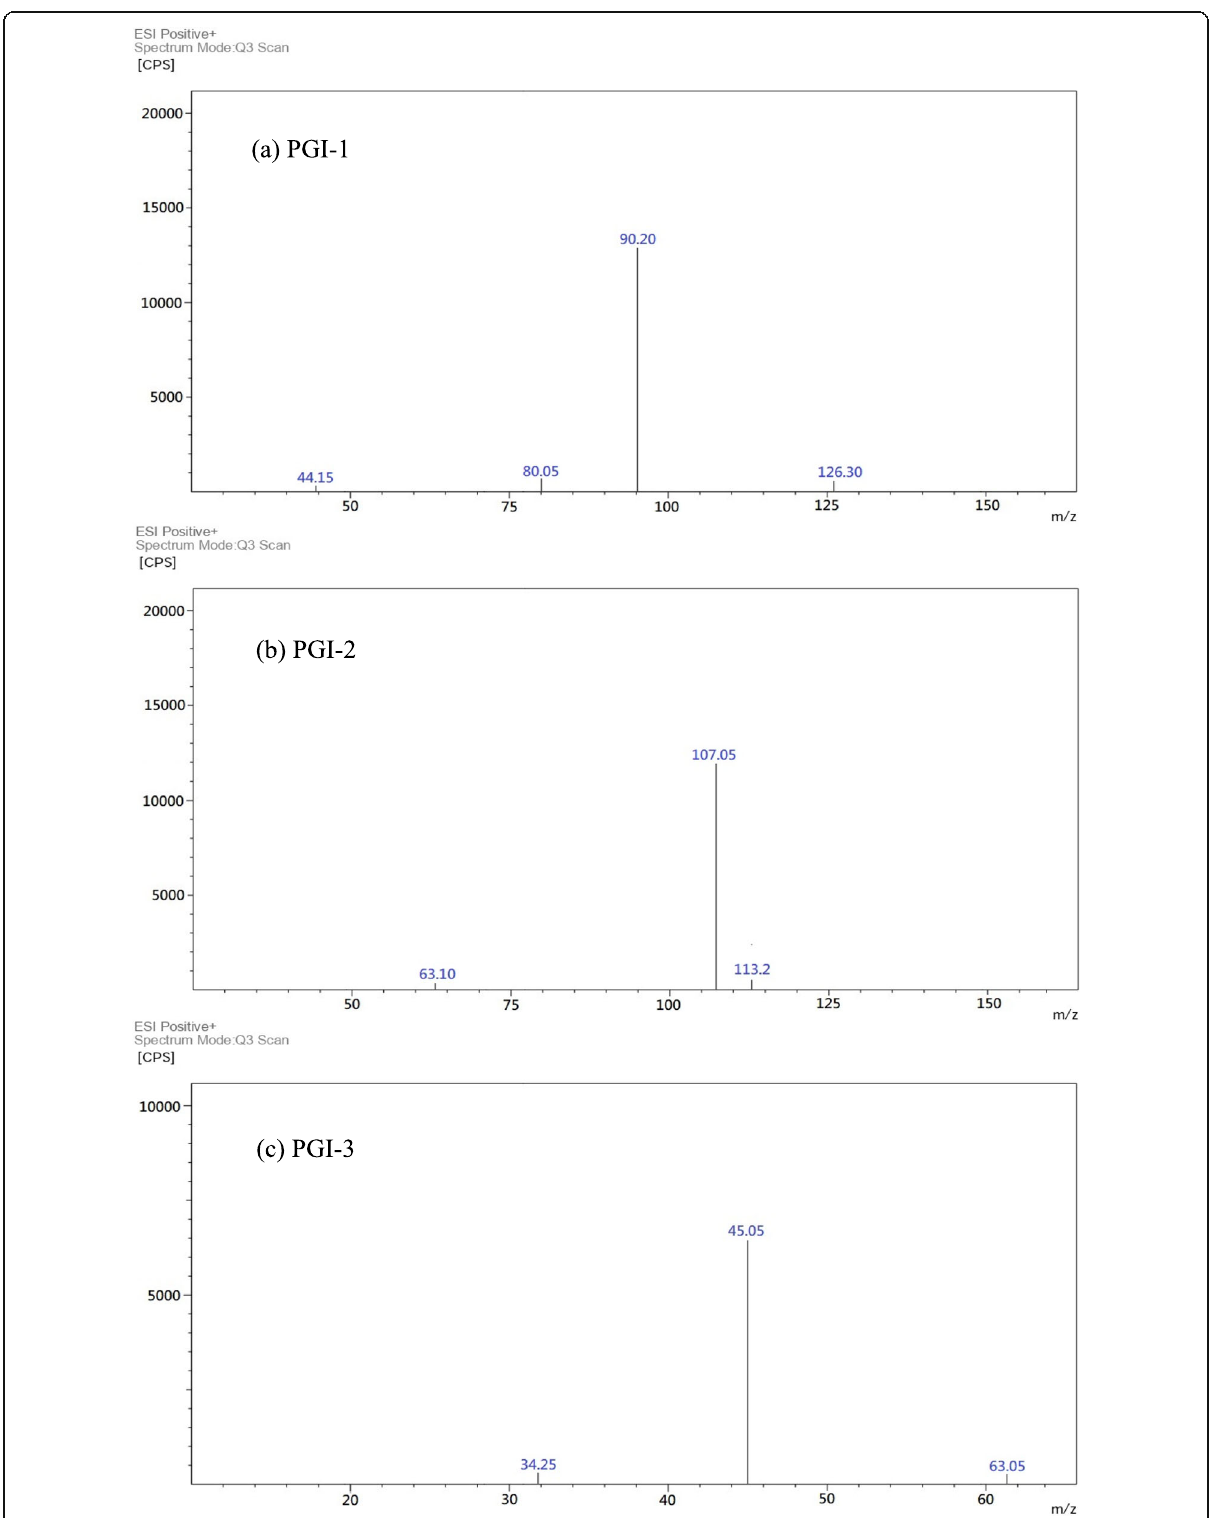
Fig. 2 Fragmentation pattern of a PGI-1, b PGI-2, and c